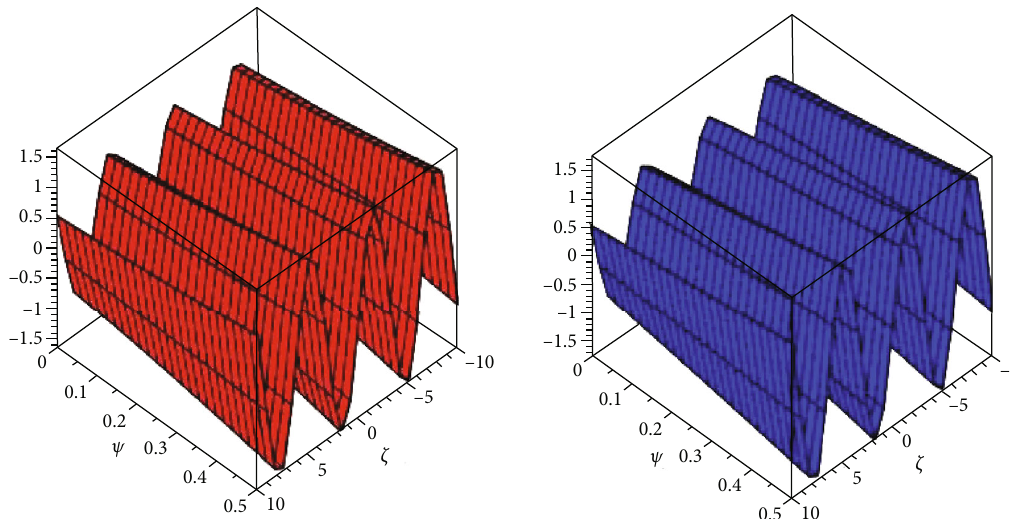
Figure 5: The YDM solution of example 1 of μ ð ζ , Ψ Þ at δ = 1 , and 0 : 8 .